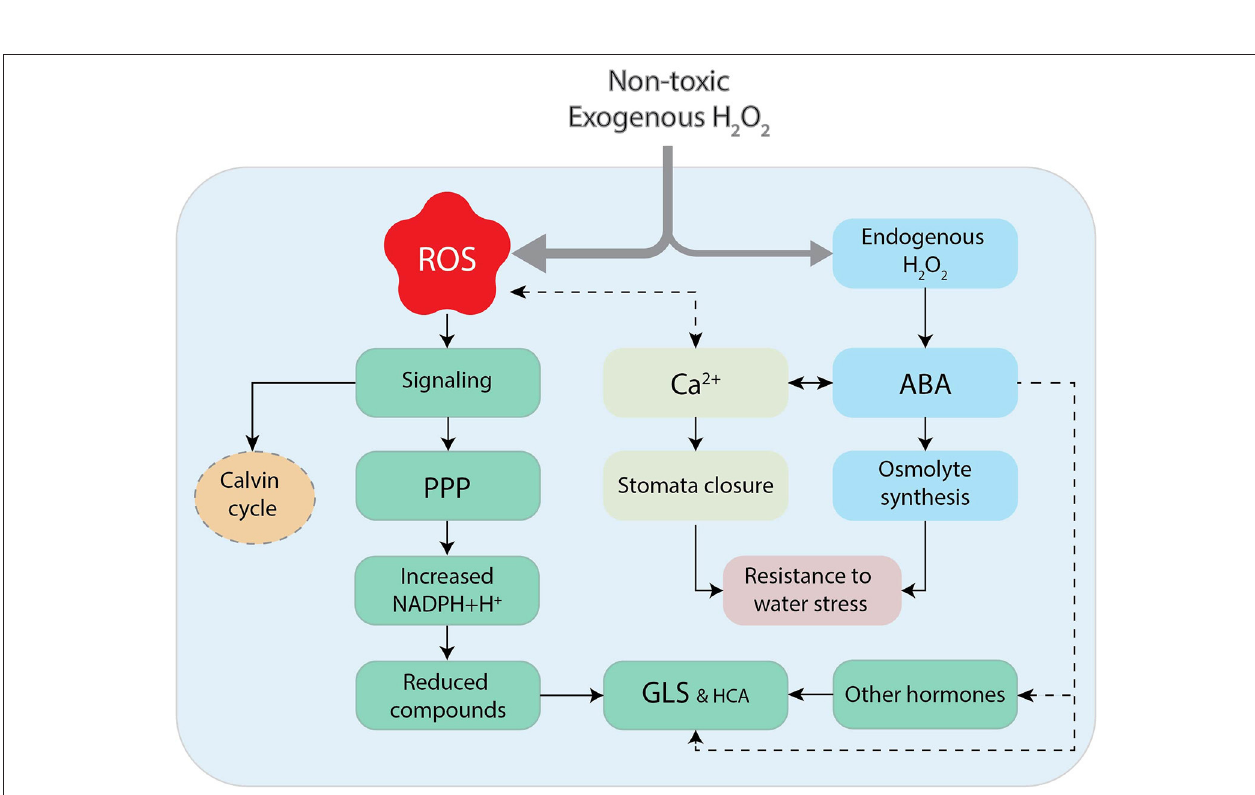
FIGURE 8 | The hypothetical oversimplification of nontoxic exogenous application of H 2 O 2 to broccoli florets. The exposure of florets to H 2 O 2 could derive into the apparition of reactive oxygen species (ROS), serving as signals to reduce the Calvin cycle, favoring the accumulation reductive power (NADPH phosphate pathway (PPP) and the concomitant production of reduced compounds such as glucosinolates (GLS) and hydroxycinnamates (HCA). Exogenous H 2 O 2 could also produce the synthesis of endogenous H 2 O 2 , which in conjunction with intracellular Ca 2 + and abscisic acid (ABA), led to stomata closure and the production of osmolytes, protecting the cell from water loss. The interaction of ABA with other plant signals (JA?) is another possibility for the enhancement of glucosinolates in broccoli exposed to abiotic